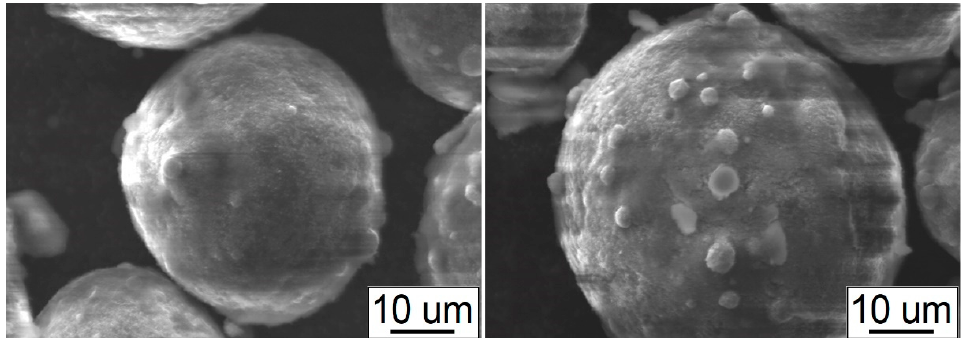
Figure 4. SEM images of the AlSi10MgCu powder particles coated with nanodiamond.